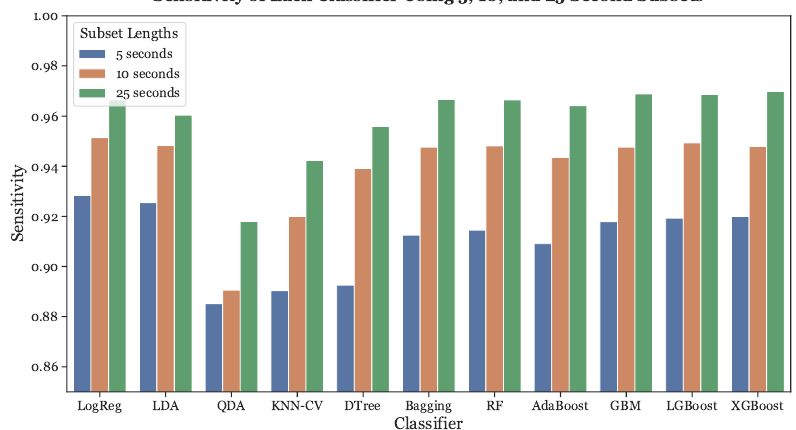
Figure 11. Sensitivities across all subset lengths (5, 10, and 25 s) using